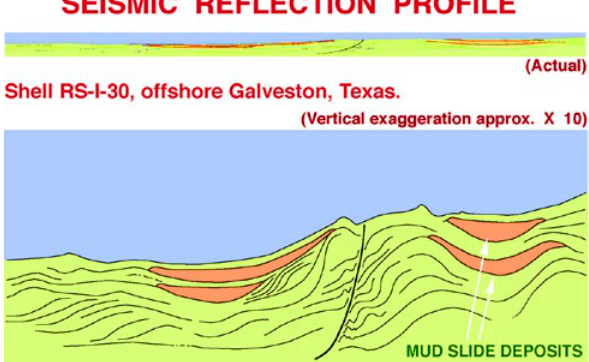
Figure 36. A Shell reflection profile reveals large volume mudslide deposits offshore Galveston, Texas. Wilhelm and Ewing 14 , 1972, fig.11.